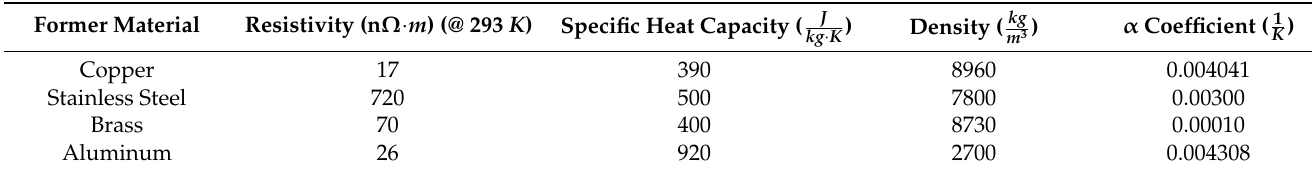
Table 4. Properties of metallic materials that are used as former for the understudied DC HTS